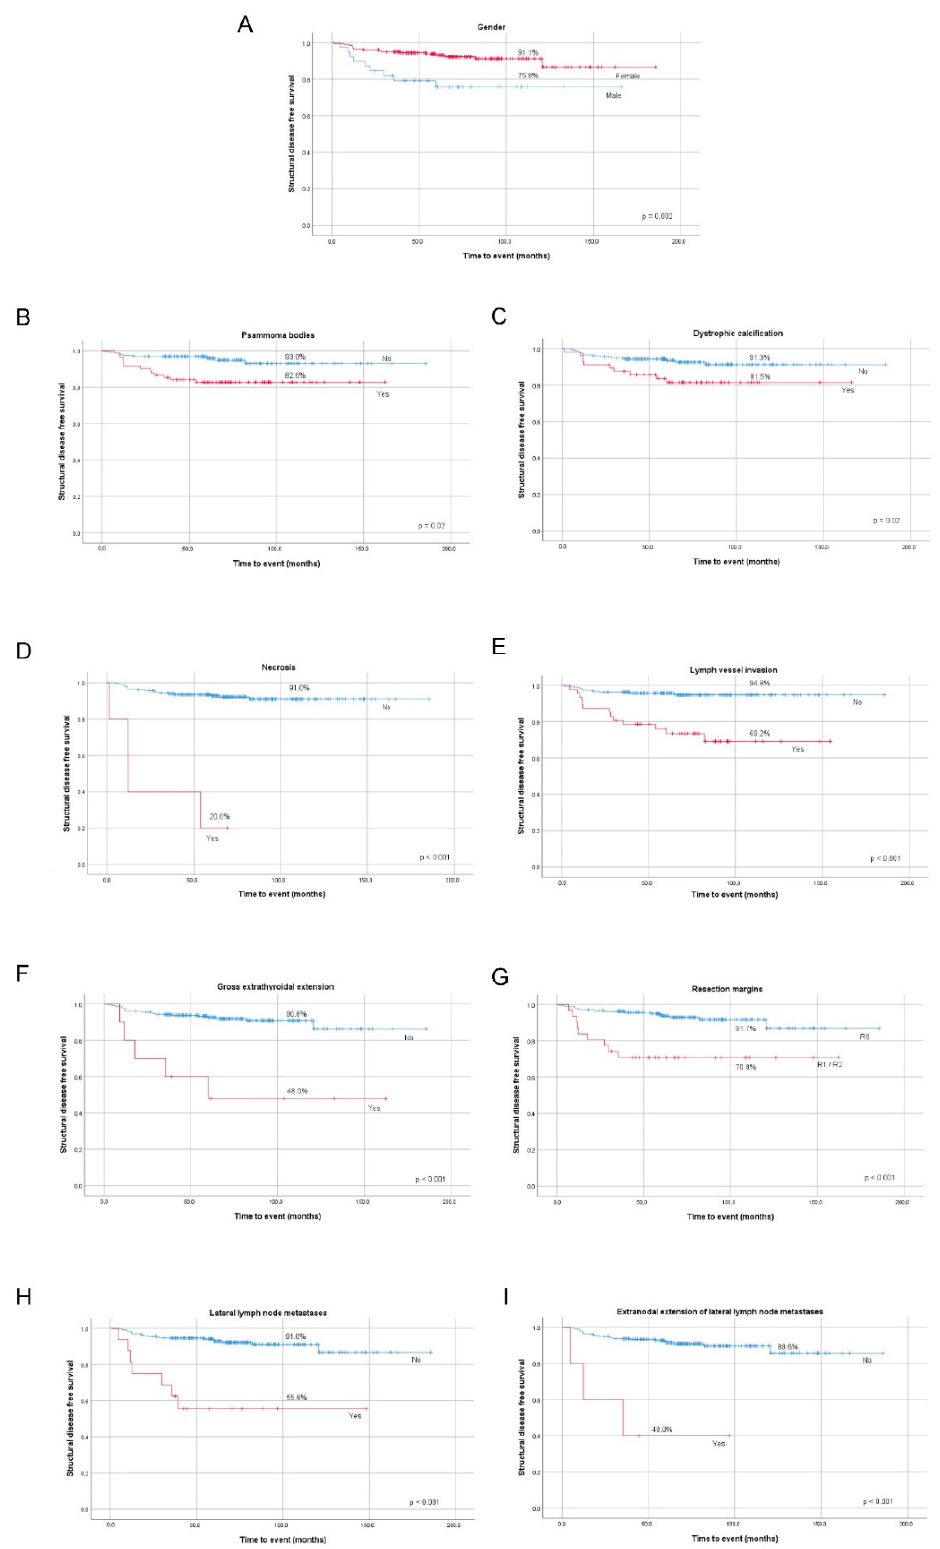
Figure 2. Kaplan–Meier curves of PTC structural disease status by gender ( A ), presence of psammoma bodies ( B ), presence of dystrophic calcification ( C ), presence of necrosis ( D ), lymph vessel invasion ( E ), gross extrathyroidal extension ( F ), resection margins ( G ), presence of metastasized lateral lymph nodes ( H ), and extranodal extension of metastasized lateral lymph nodes ( I ).